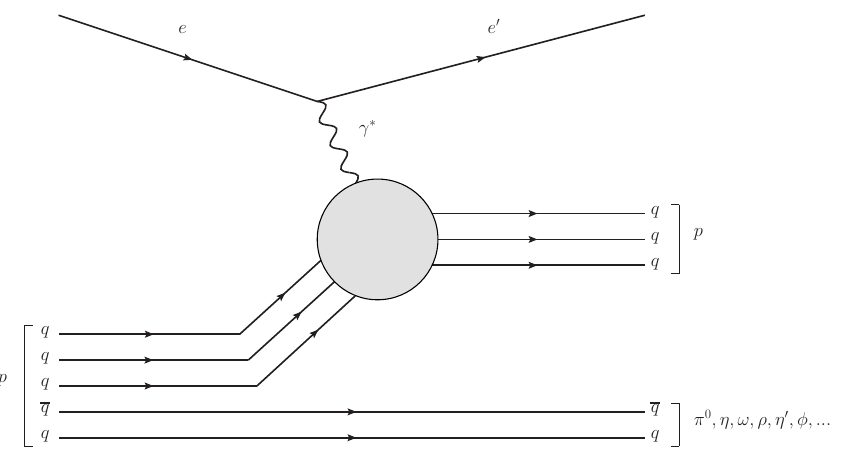
Figure 1: Illustration of u -channel (backward) meson production (a.k.a. knocking